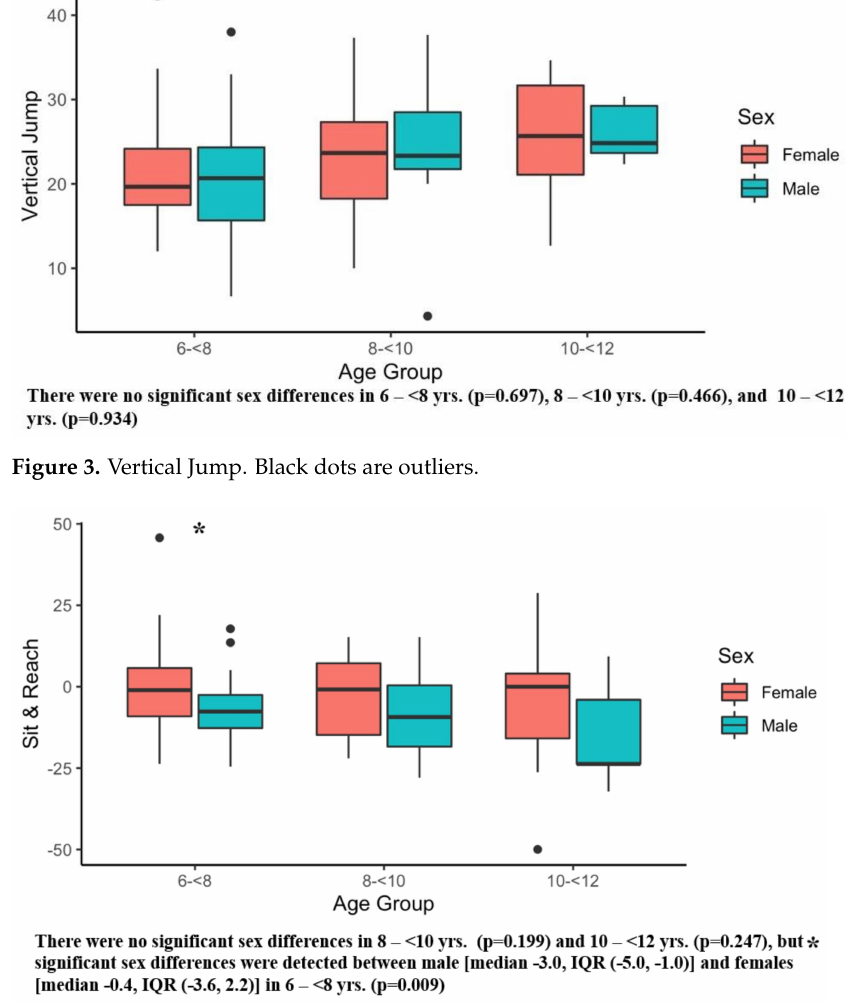
Figure 4. Sit and Reach. Black dots are outliers.